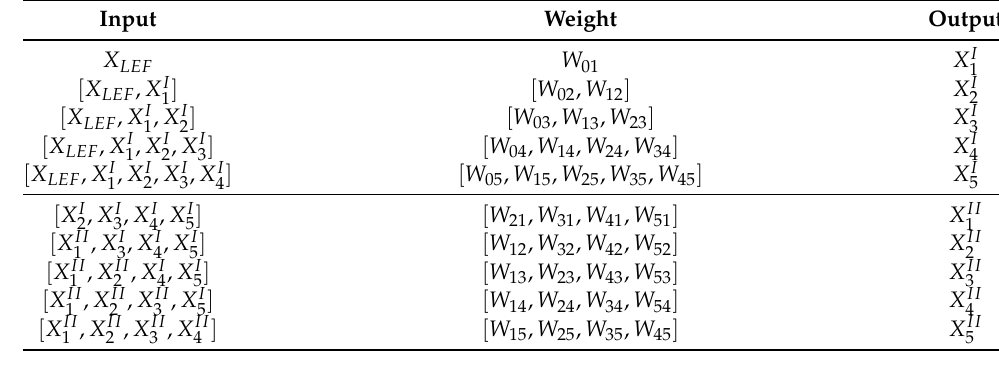
Table 1. Forword propagation of LEFB.